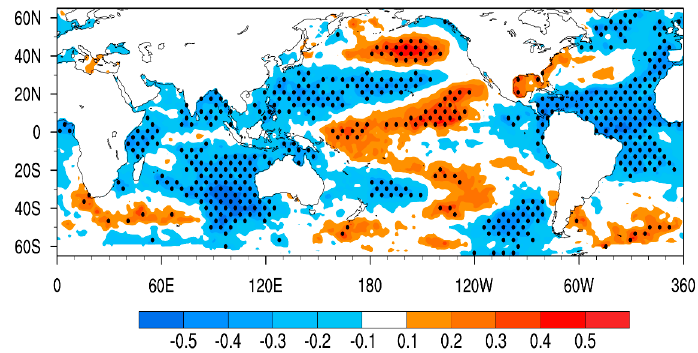
Figure 10. Correlation maps of the summer (JAS) SCSSMI with the previous spring (FMA) SST anomalies. Areas with correlation significant at the 90% confidence level are stippled.